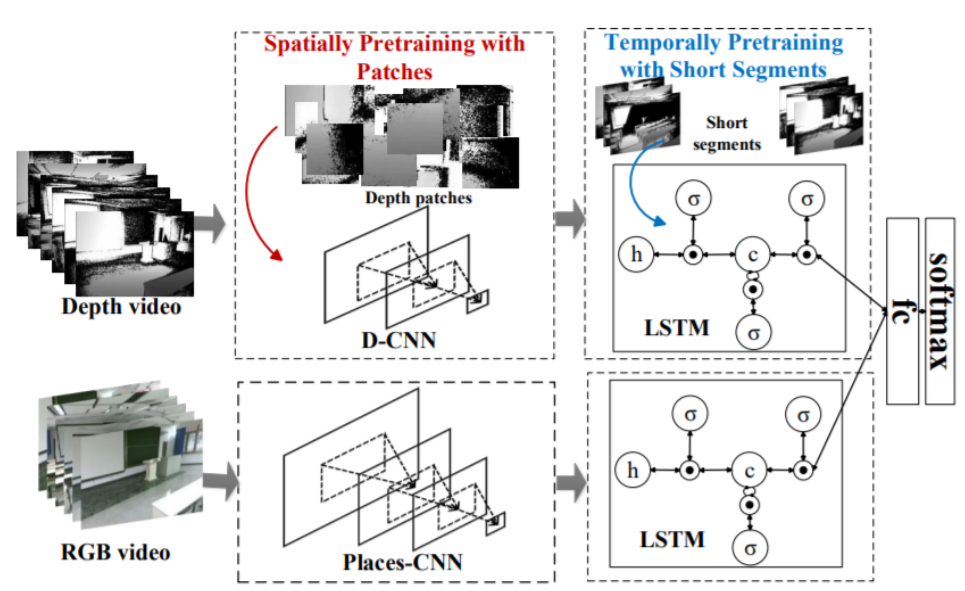
Figure 25. The CNN-RNN [78] architecture for video recognition.